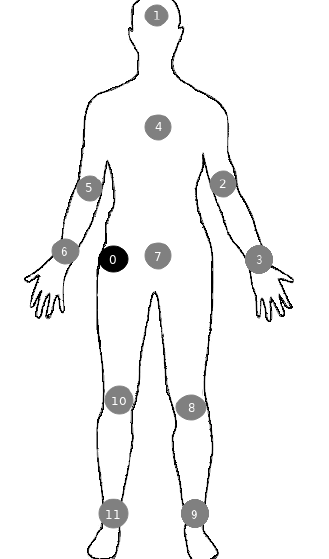
Figure 12. WBAN topology with 12